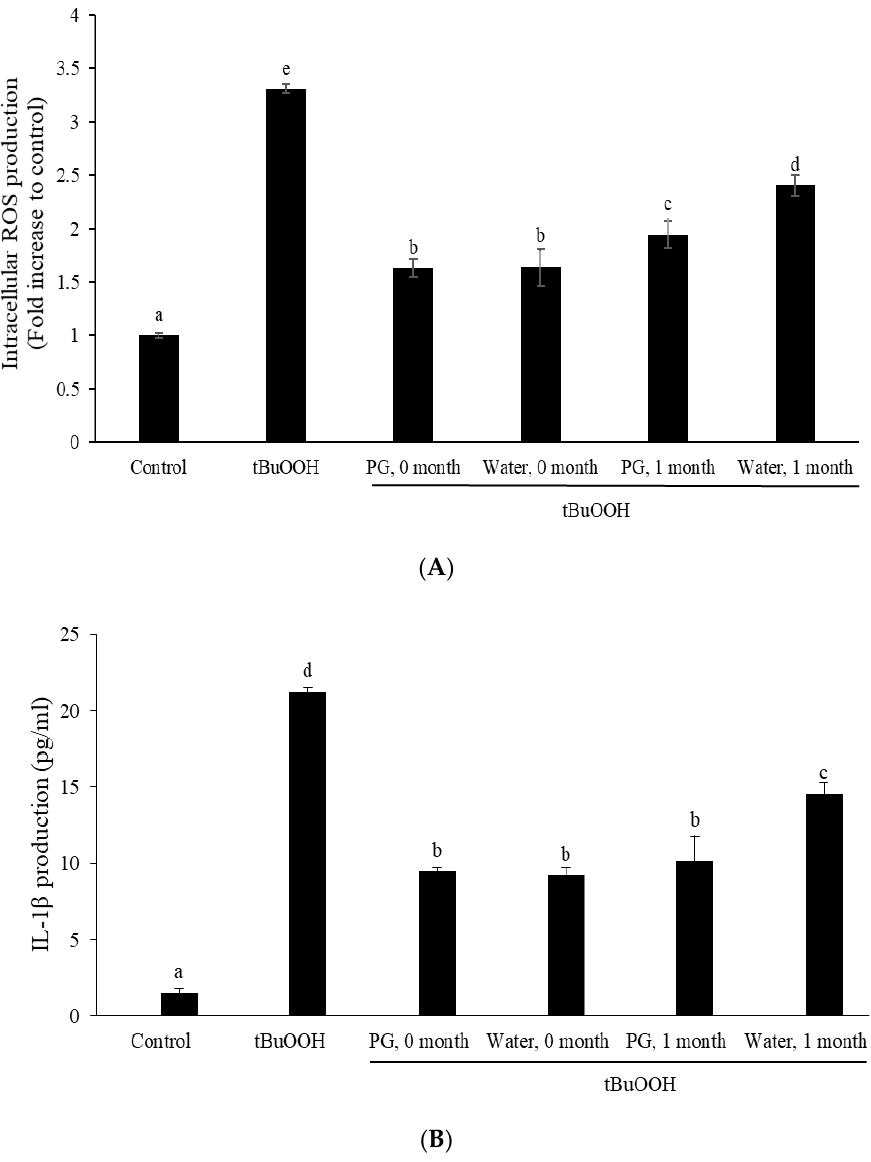
Figure 5. Effects of Scutellaria baicalensis extract (SBE) storage in 20% PG and water for one month on intracellular ROS ( A ) and IL-1 β ( B ) production by tBuOOH stimulation in human keratino- cytes. The data are presented as the mean ± SD (n = 3). Letters indicate significant differences within each experiment at p <